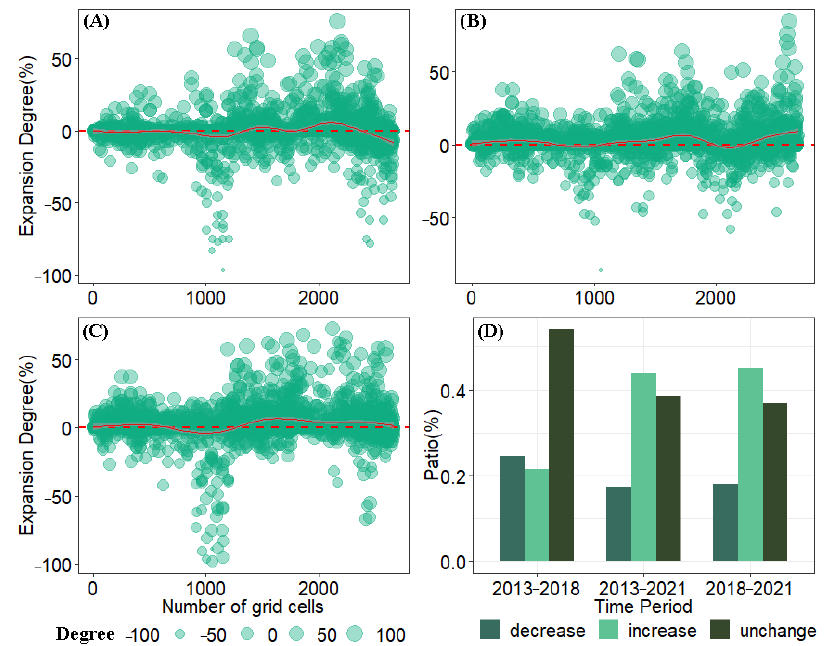
Figure A5. Plot showing the expansion of pond mariculture in the study area at the grid scale including ( A ): 2013–2018, ( B ): 2018–2021, ( C ): 2013–2021, and ( D ): Patio changes in pond mariculture during the different periods.